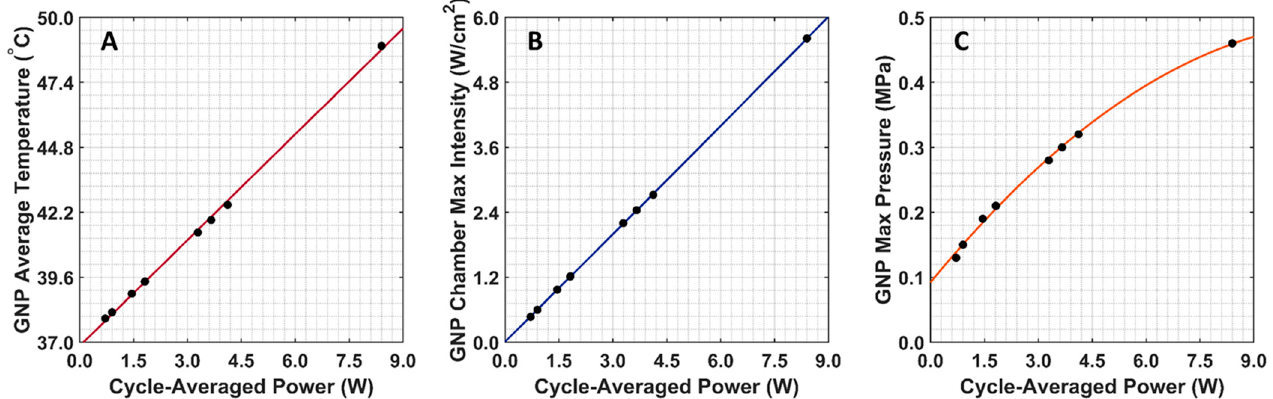
Figure 6. COMSOL-simulated GNP chamber average temperature and time-averaged intensity and pressure for all nine LIPUS total acoustic power settings. ( A ) Average GNP chamber temperature; ( B ) maximum time-averaged intensity in the GNP chamber; ( C ) maximum pressure in the GNP chamber.